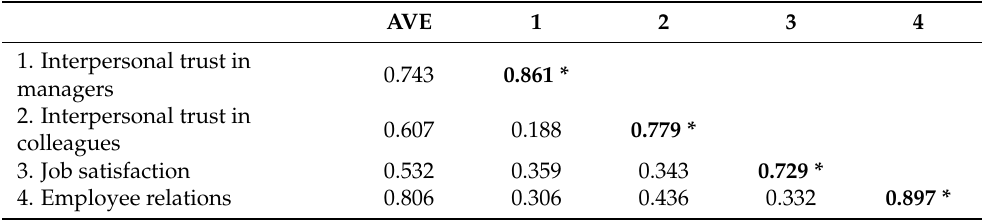
Table 4. Correlations between